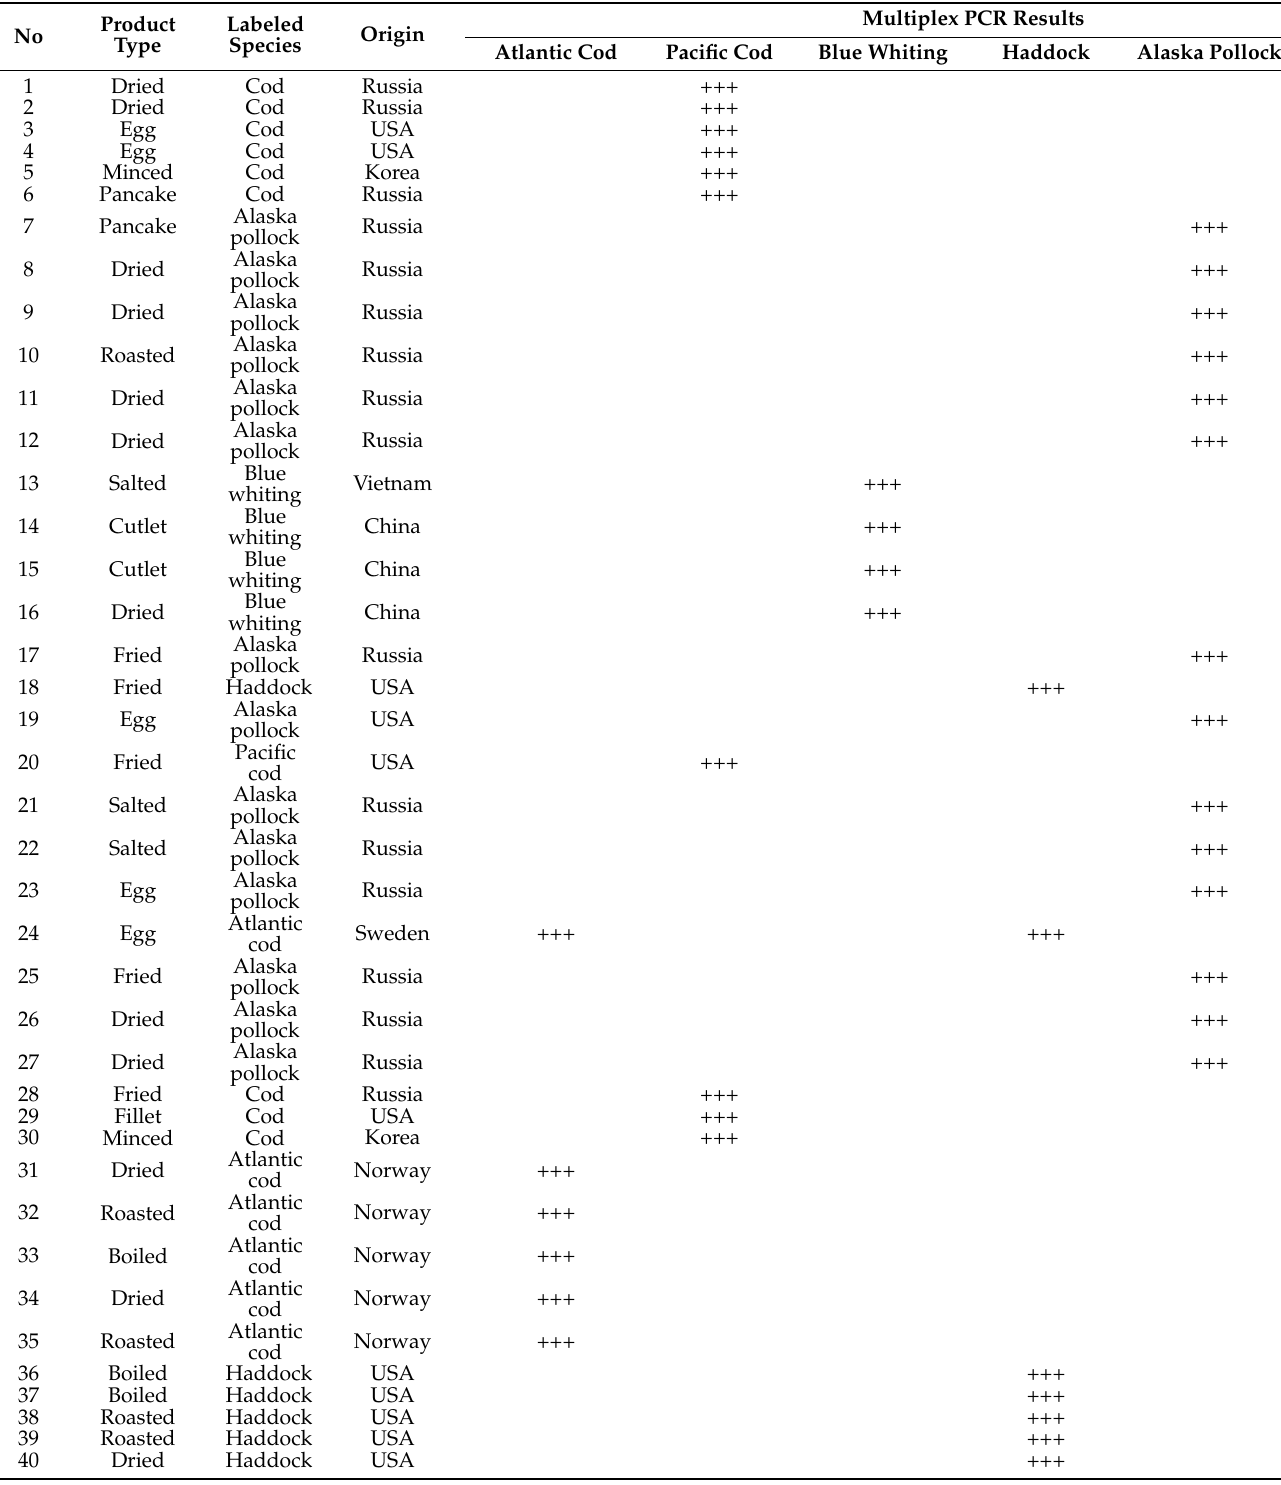
Table 2. Application and validation results of the multiplex PCR assay to commercial